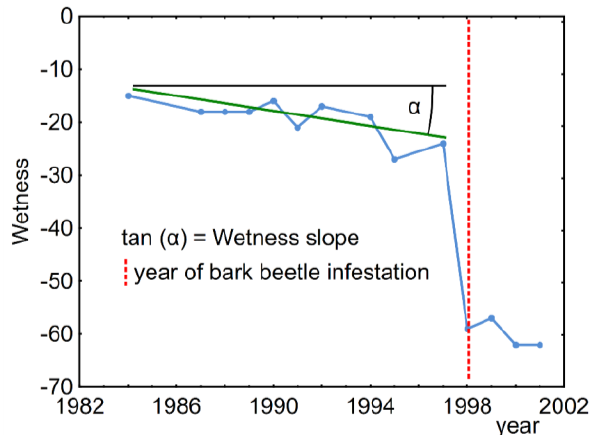
Figure 2. Spectral trajectory of Wetness TC component in a given pixel calculated as the slope of linear regression of Wetness for consecutive years from 1984 to one year before the year for which the model was calibrated. Slope was calculated for both infested and non-infested pixels; the infested one is shown as an example.